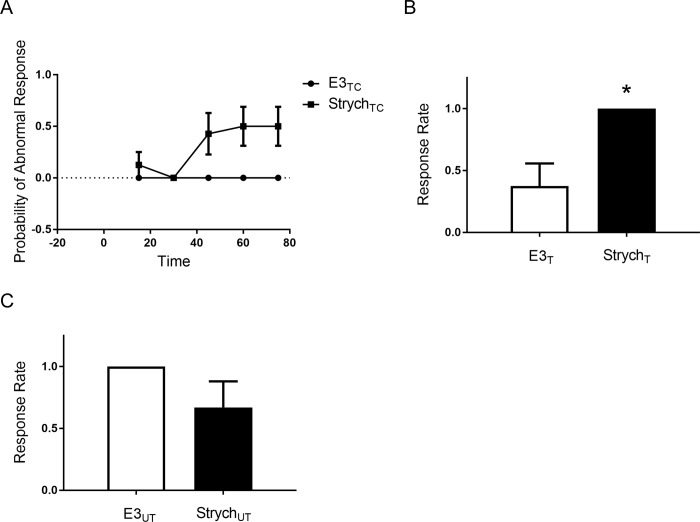
Strychnine blocks habituation to touch by disrupting the escape response.(a) Effect of strychnine (100 μM; StrychTC,
n = 7) or vehicle (E3TC, n = 6) on the nonhabituated escape response of larvae. A repeated measure between-groups ANOVA revealed a significant interaction between these groups (F[4, 44] = 5.077; p < 0.05). Posthoc revealed that the differences in abnormal responses between the StrychTC and E3TC groups were significant for the 60-min (StrychTC, 0.50 ± 0.19; E3TC, 0.00 ± 0.00), and 75-min posttests (StrychTC, 0.50 ± 0.19; E3TC, 0.00 ± 0.00) (p < 0.05), but not for the 15-min (StrychTC, 0.13 ± 0.13; E3TC, 0.00 ± 0.00), 30-min (StrychTC, 0.00 ± 0.00; E3TC, 0.00 ± 0.00), or 45-min posttests (StrychTC, 0.43 ± 0.20; E3TC, 0.00 ± 0.00) (p > 0.05). (b) Effect of strychnine on habituation of the escape response. To determine whether the altered startle response observed in strychnine-treated fish could still undergo habituation, we exposed groups to strychnine (StrychT, n = 6) or vehicle (E3T, n = 8) for 18–24 h prior to the onset of behavioral testing/training. One minute after habituation training, the StrychT group was significantly (t
[12] = 2.93; p < 0.05) more responsive than the E3T group. (c) Comparison of the effects of strychnine on fish that did not receive habituation training. The difference between the group treated with strychnine for 18–24 h (StrychUT, n = 8) and the group treated with vehicle (E3UT, n = 8) was not significant (t
[14] = 1.53; p = 0.15).